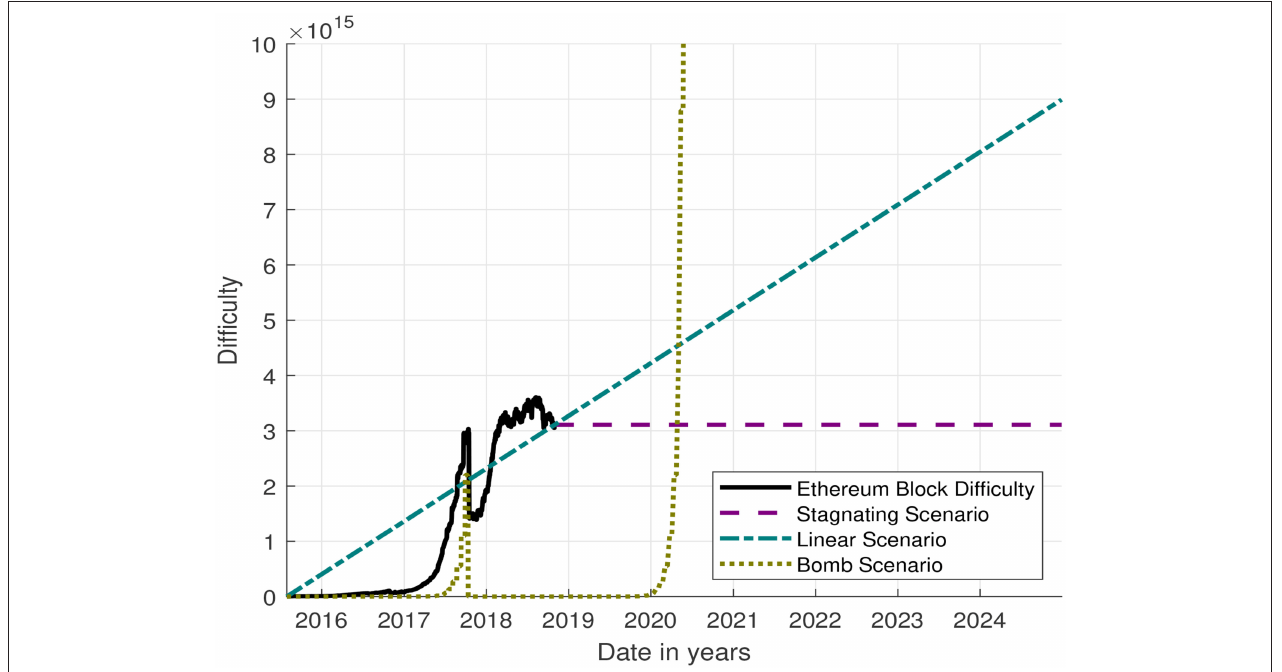
FIGURE 3 | Past Ethereum block difficulty development according to Etherscan (2018) and exponential, linear, and stagnating scenarios for the future.